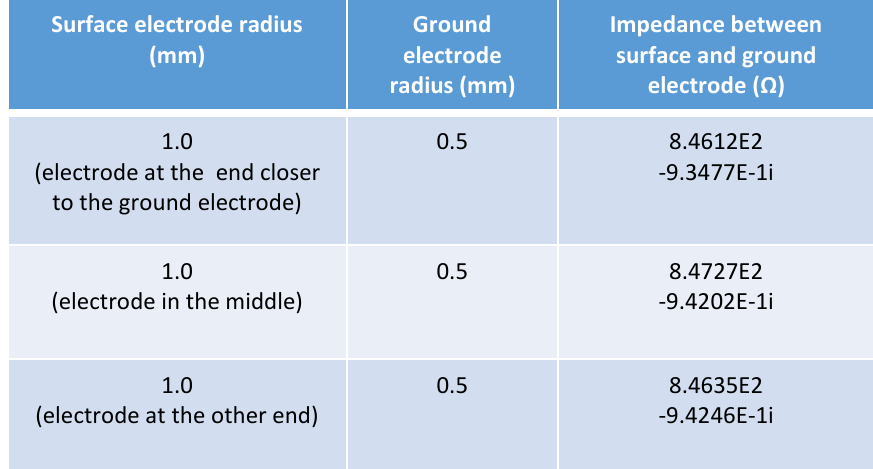
Table.8: Impedance measurement at 1MHz with one of the 32 surface electrodes as terminal (8 electrodes in 4